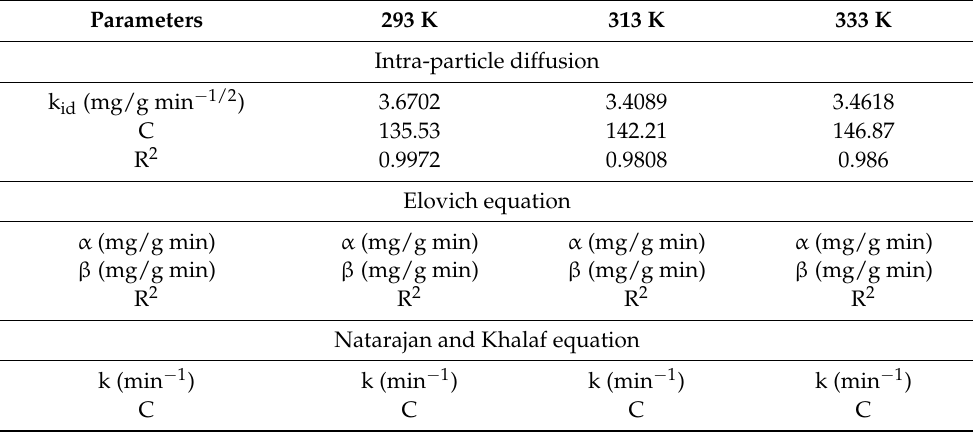
Table 3. Parameters of other kinetic models for adsorption of BB-3 on